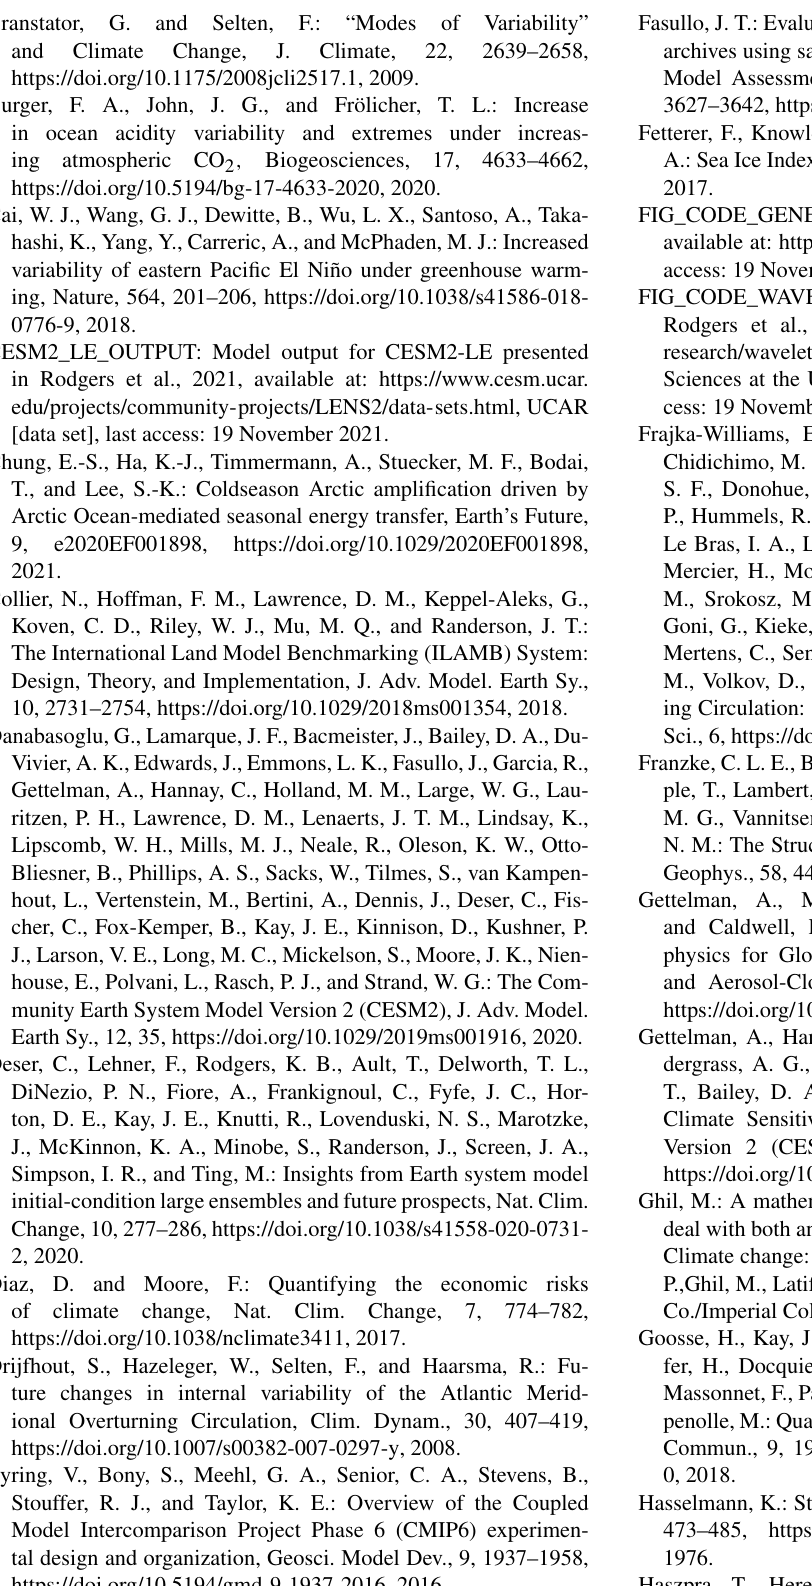
FIG_CODE_WAVELET: Figure code Fig. 3 wavelet analysis